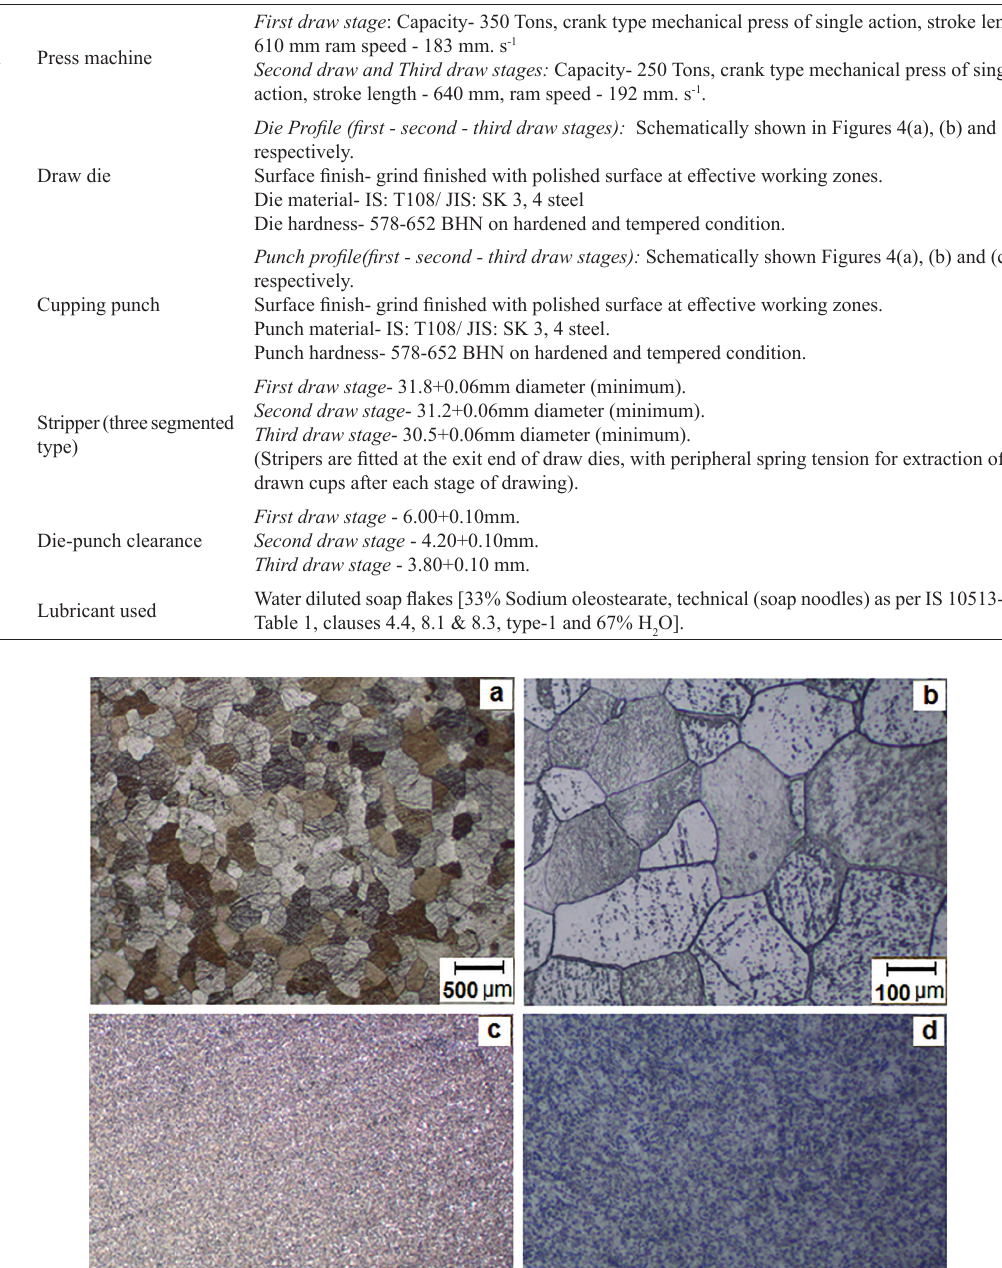
Table 2: Equipments, tools and process parameters of multistage drawing (a) Equipments/ tools (b) Technical details/ process parameters